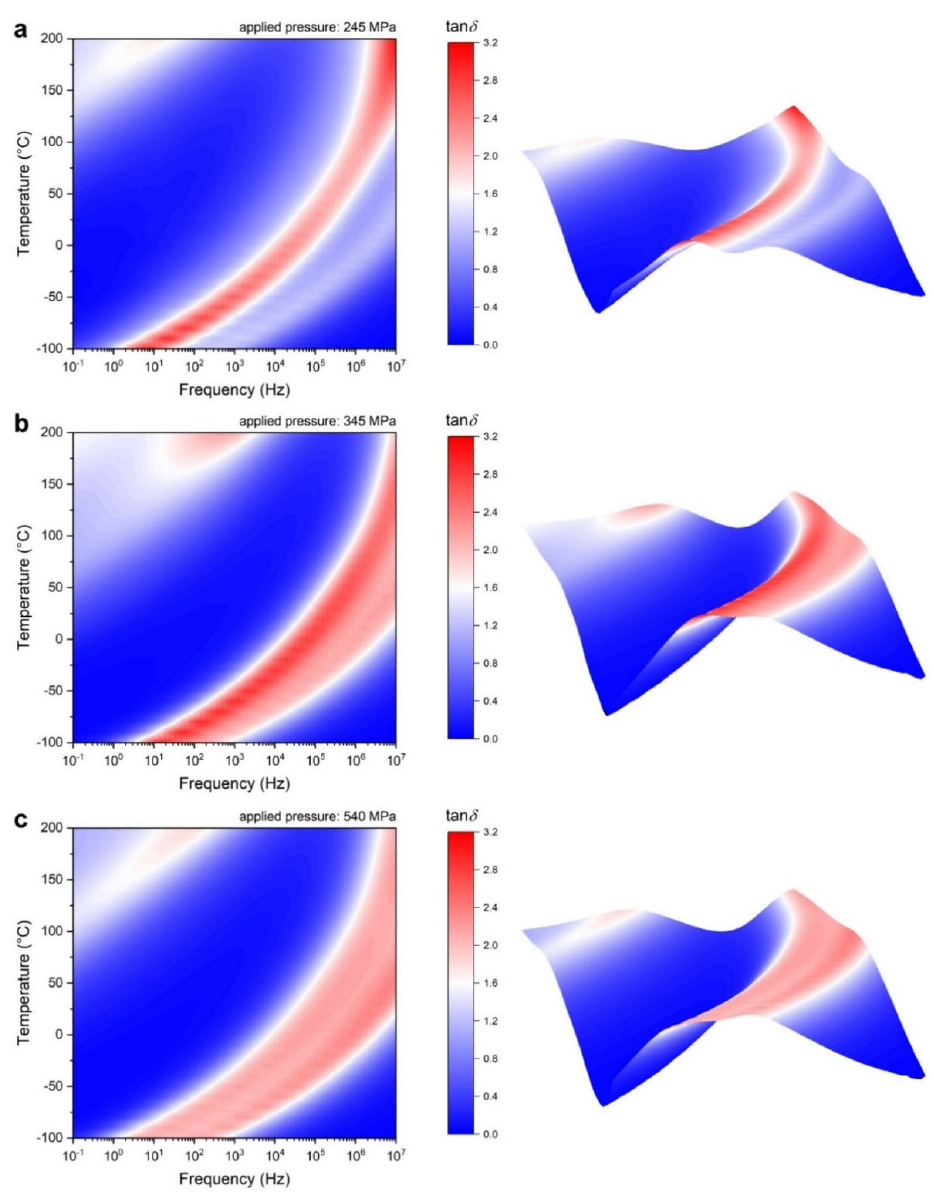
Figure 13. Parametric 2D and 3D phase-space mappings of the dissipation factor tan δ of permittivity scanned over a broadband frequency range of 10 − 1 to 10 11 Hz and for temperatures ranging from 200 °C to − 100 °C. Scans for NASICON pellets assembled by applying pressure levels of ( a ) 245 MPa, ( b ) 345 MPa, and ( c ) 540 MPa are displayed. Phase-space mappings reveal the primary relaxation band as a diagonal ridge in direct association with the corresponding feature observed in conductivity mappings as well as a second relaxation band initiated at the transition temperature of the monoclinic-to-rhombohedral lattice structure for NASICON. Dissipation scales adhere to the common colormap on the right of